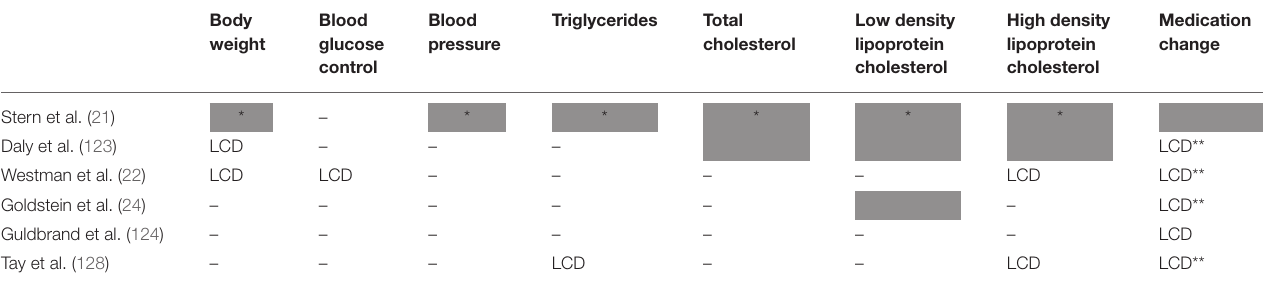
TABLE 2 | Summary of significant differences in randomised controlled trials comparing low carbohydrate dietary approaches (carbohydrate intake below 130 g/day or 26% total energy) with any control diet in people with Type 2 diabetes (minimum 50 participants and 3 months